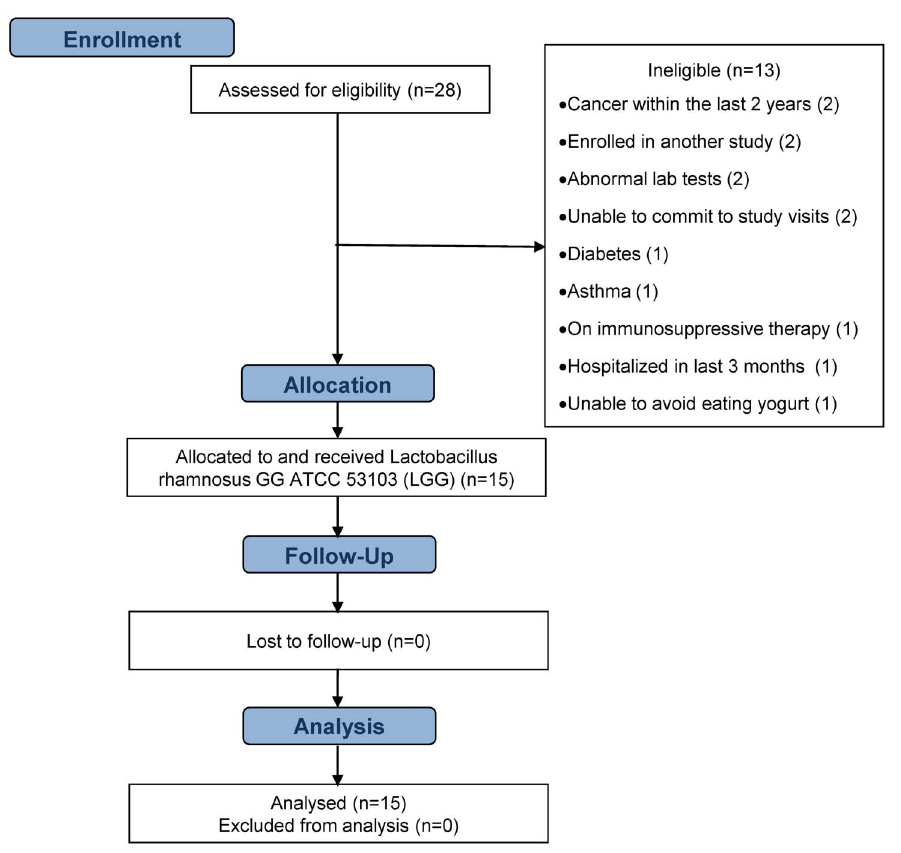
Figure 1. Participant flow